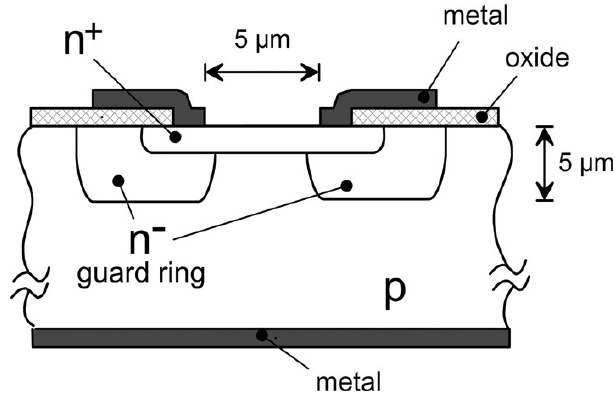
Figure 5: Planar SPAD Si device with a 10 µ m active area and deep- diffused n- guard rings. From